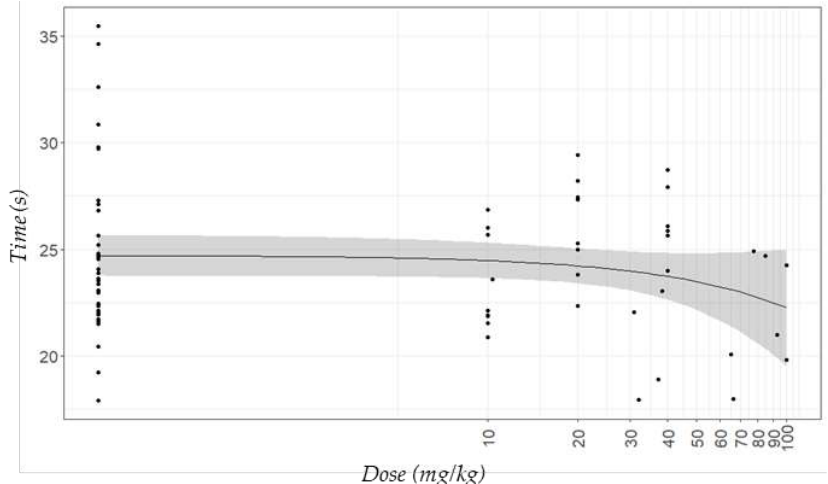
Figure 4. Predicted plot ( ± 95% confidence interval) for the latency to recumbency from the onset gas exposure (CO 2 ) during euthanasia with this gas considering the actual doses of the sedative tiletamine-zolazepam in C57BL/6 mice. Each dot represents an individual mouse.